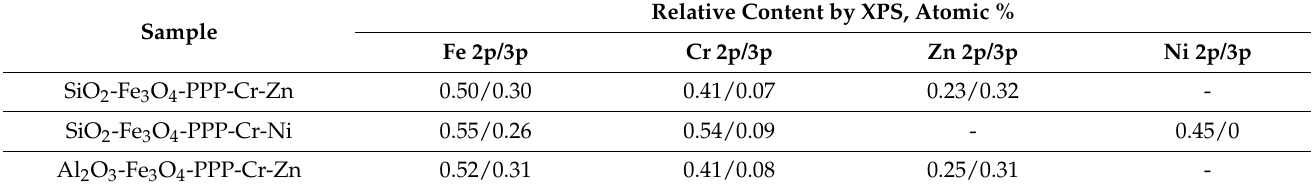
Table 1. Atomic concentrations of metals for Cr-, Zn-, and Ni-containing magnetic nanocomposites determined by HR XPS for 2p and 3p